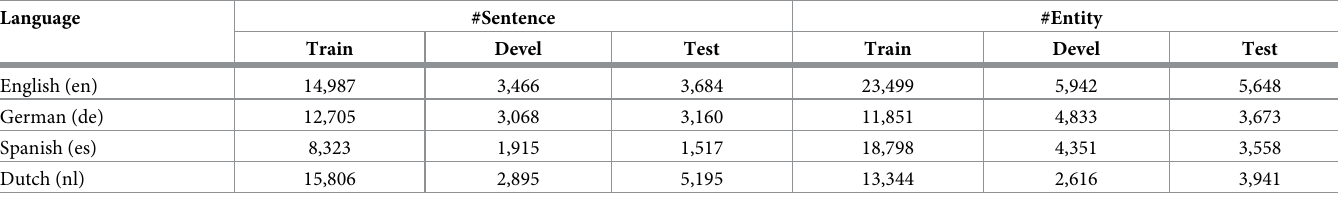
Table 1. Data statistics, where the number of sentences and entities are reported, and Devel indicates the development